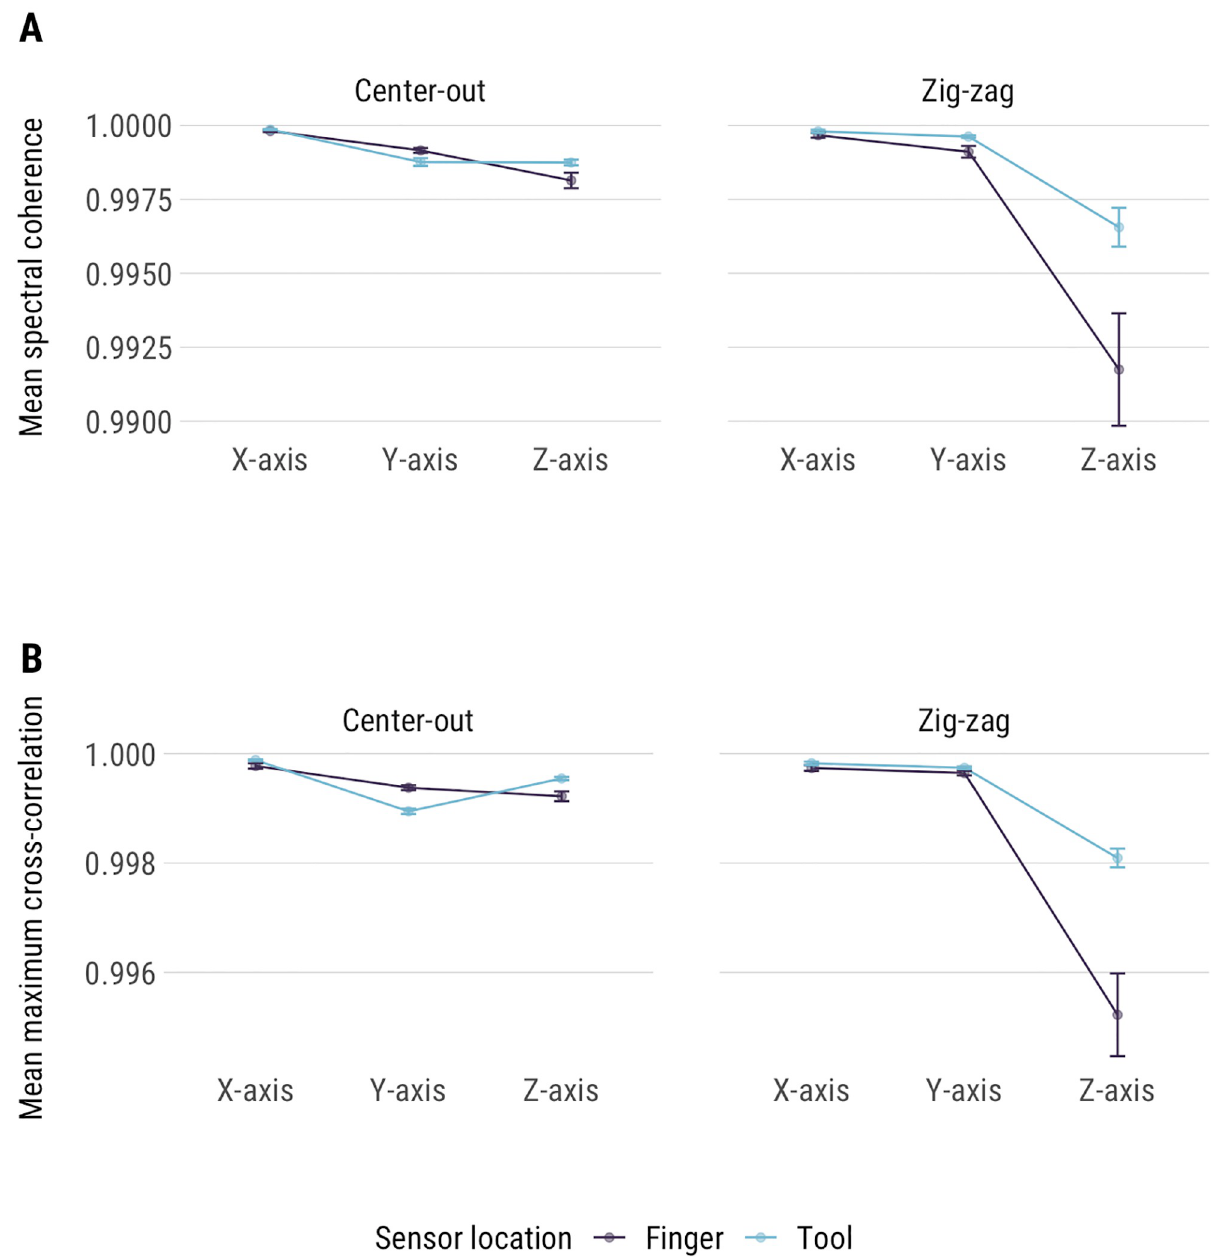
Fig 4. (A) Mean cross-spectral coherence values for all tasks. (B) Mean cross-correlation values for all four tasks. Error bars are 95% confidence